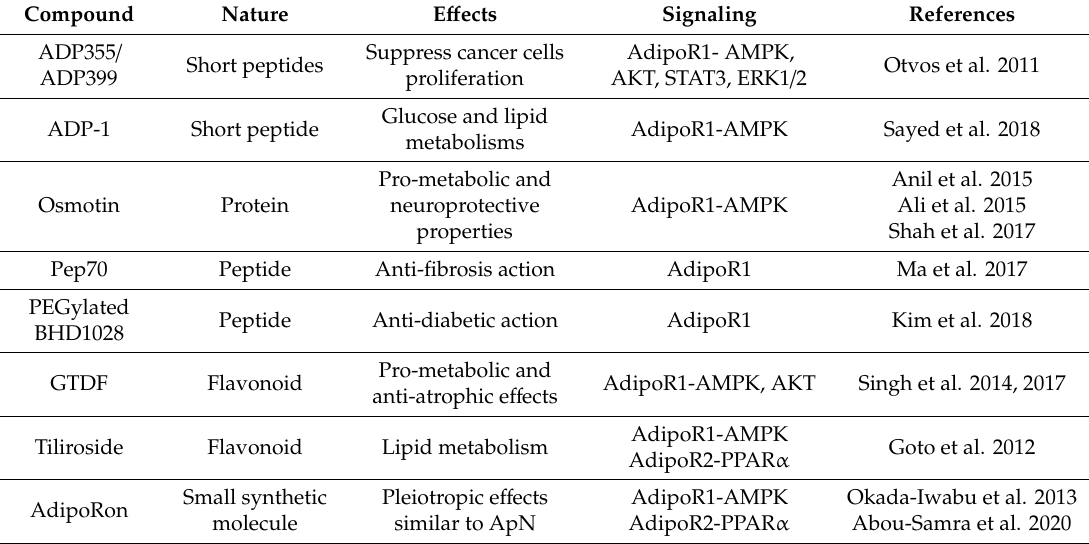
Table 1. Adiponectin mimics. Compounds that specifically bind to AdipoRs and greatly mimic several beneficial and protective e ff ects of